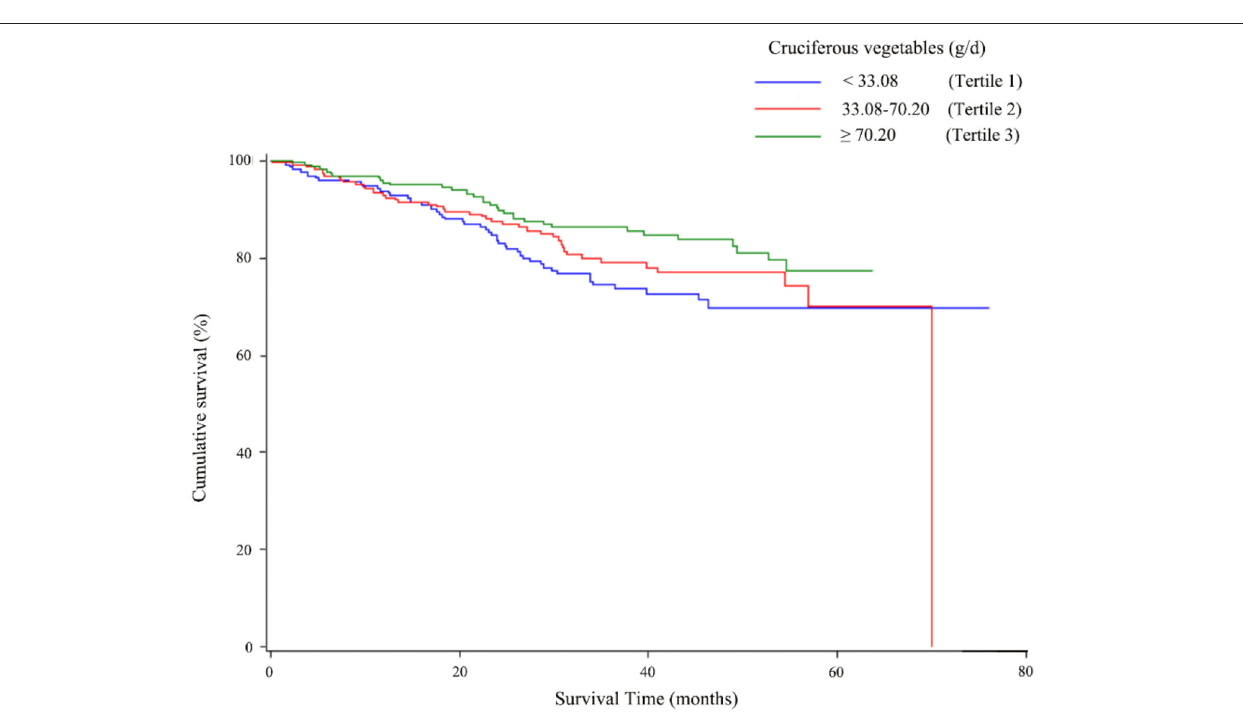
FIGURE 2 | Kaplan–Meier survival curves for total cruciferous vegetables